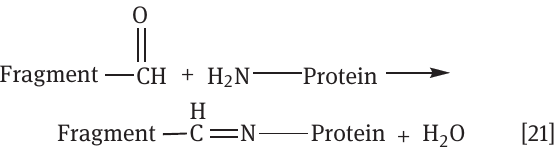
Values represent the rate of protein modification/rate of peroxyl radical production